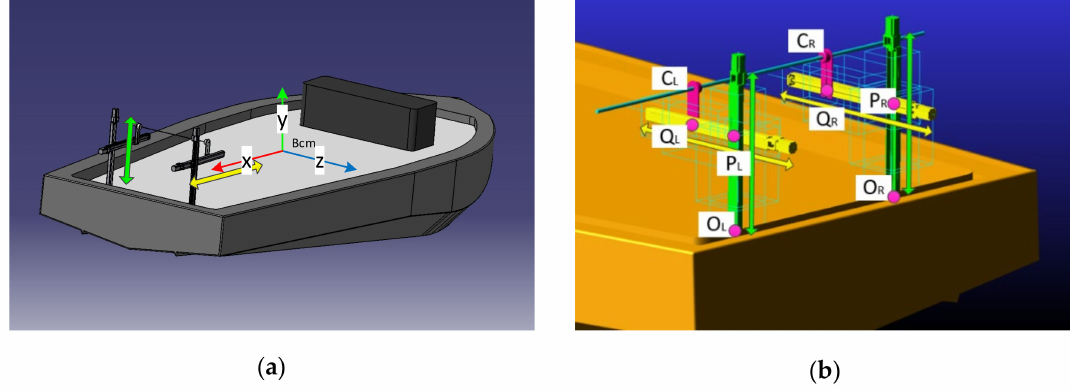
Figure 12. ( a ) Geometrical schematic of four-degrees-of-freedom compensation mechanism. ( b ) Motion pair distribution of compensation